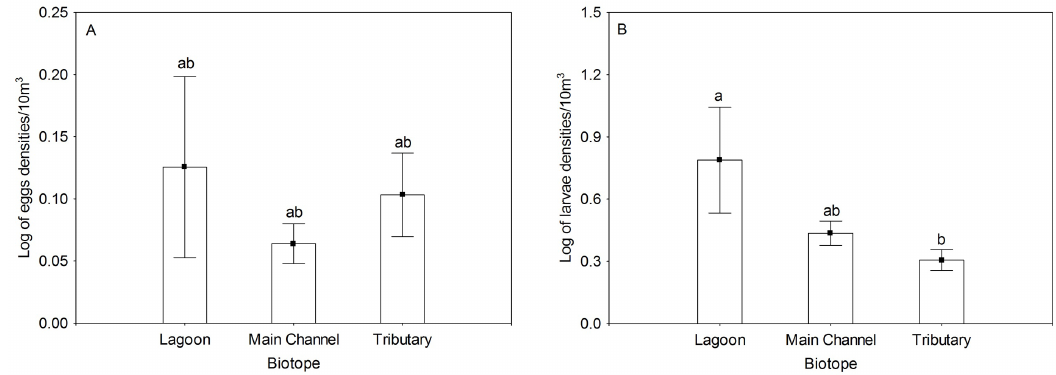
Figure 1. Density of eggs (A) and larvae (B) of fish observed in different biotopes of the Upper Paraná River floodplain between August 2013 and May 2015 (squares = mean; bars = standard error; values with different letters are significantly